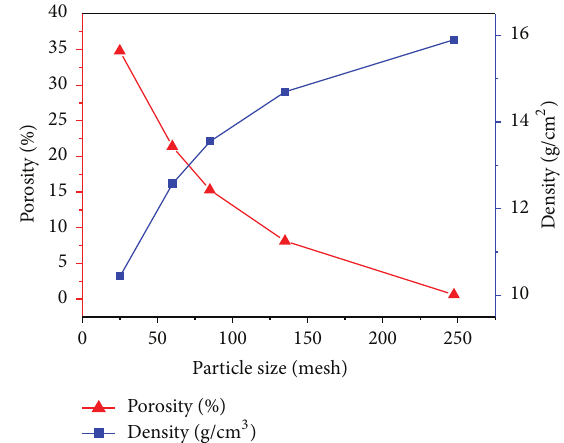
Figure 9: Porosities and densities of the bulk U-10wt%Zr alloy prepared through pressureless sintering at 1150 ∘ C for 80 min as a function of particle